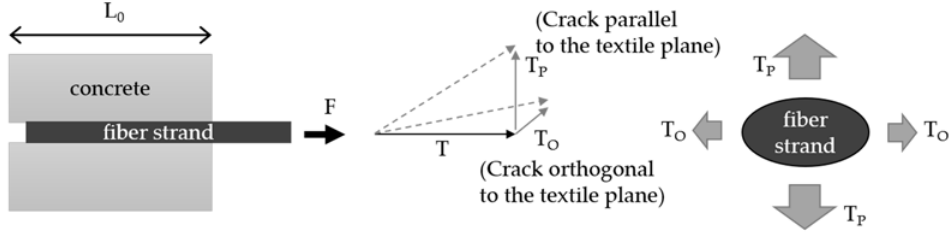
Figure 2. Terms for describing the orthogonal and parallel forces along the fiber strand.